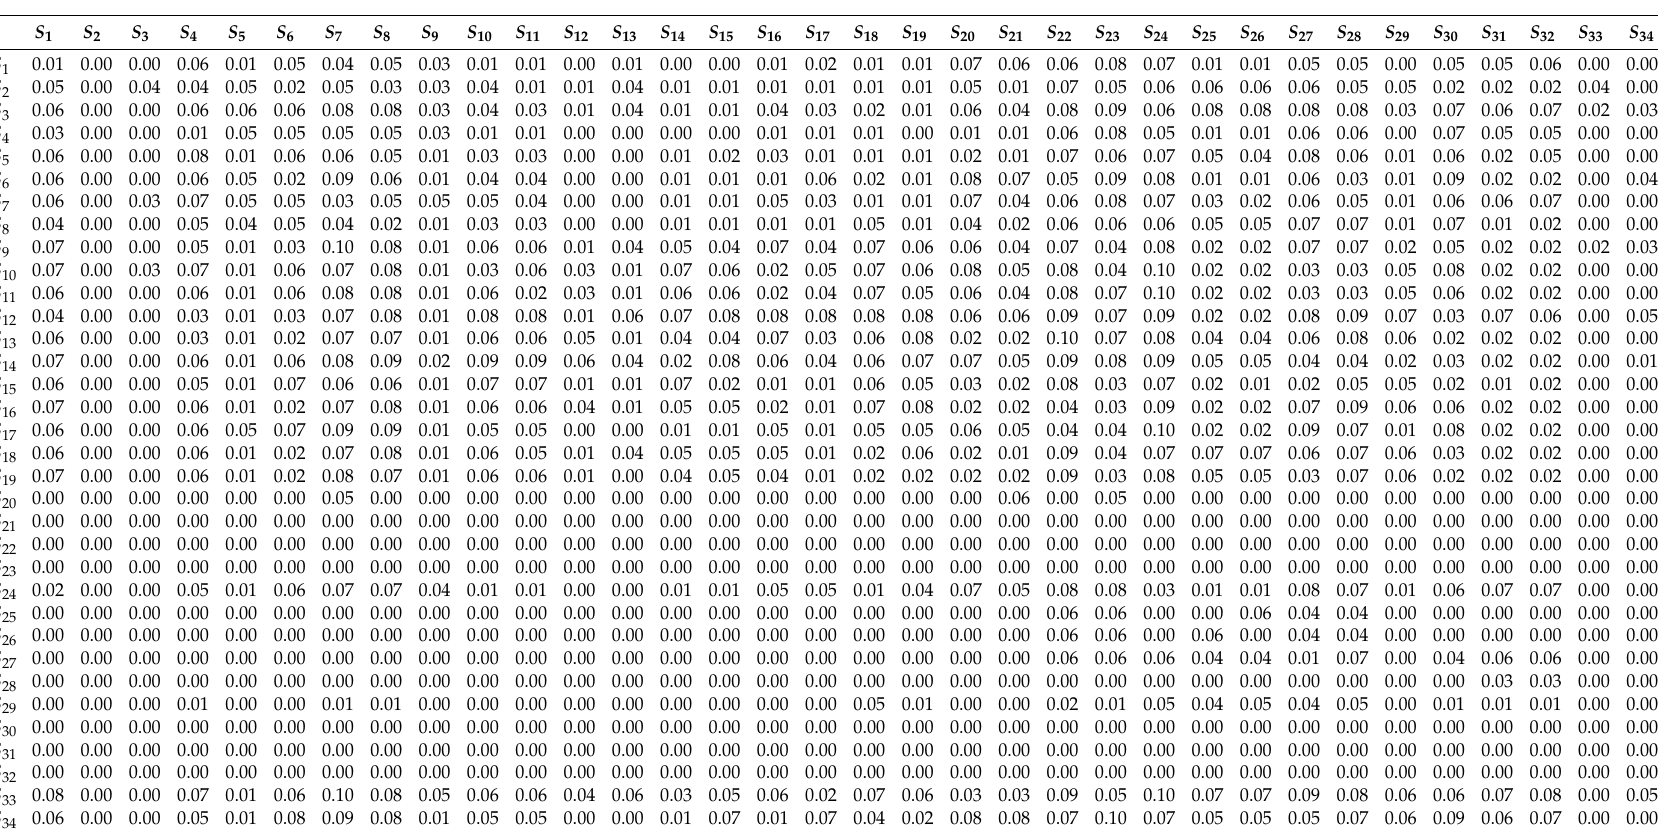
Table 3. The comprehensive relation matrix of